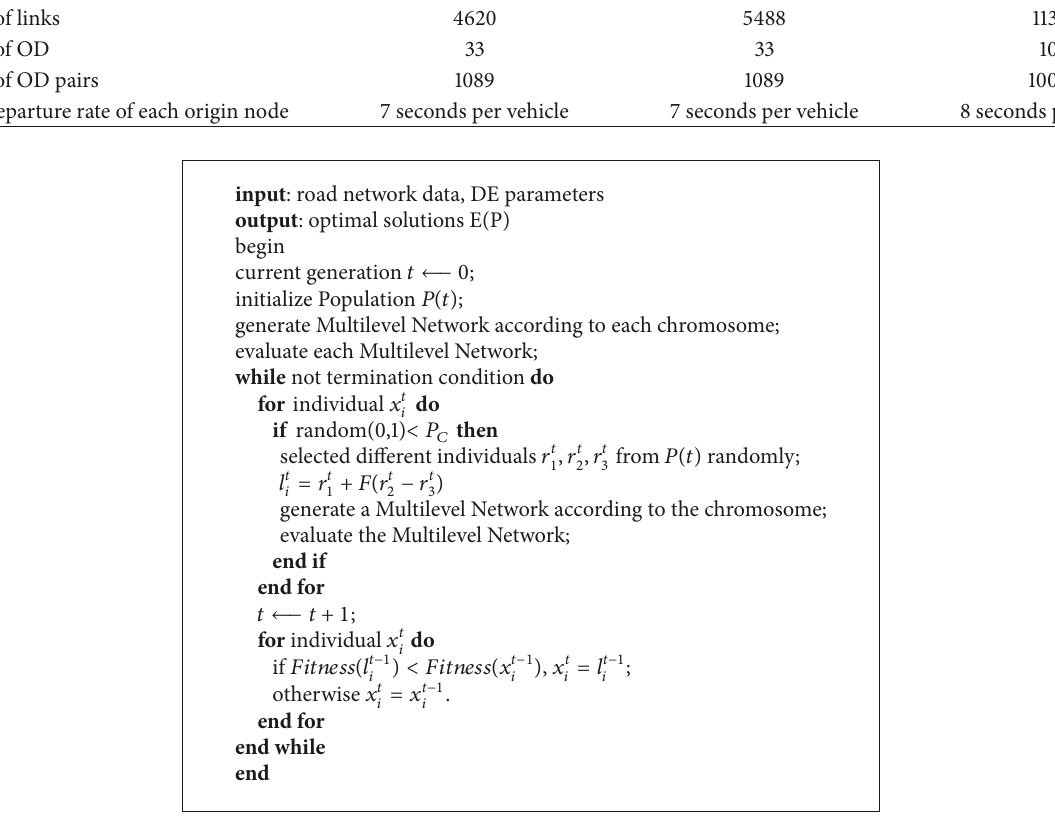
Algorithm 1: Procedure of DE based clustering.